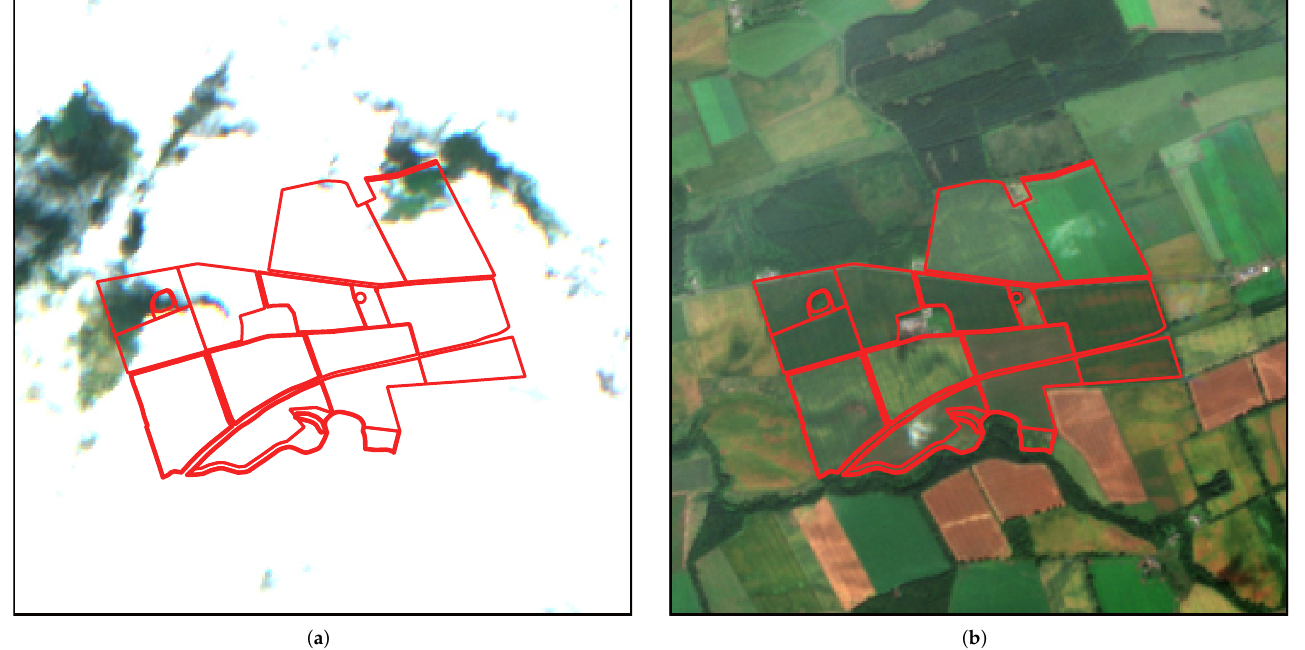
Figure 10. Sentinel-2 RGB image patch for a group of farms (highlighted in red) in Scotland acquired two days